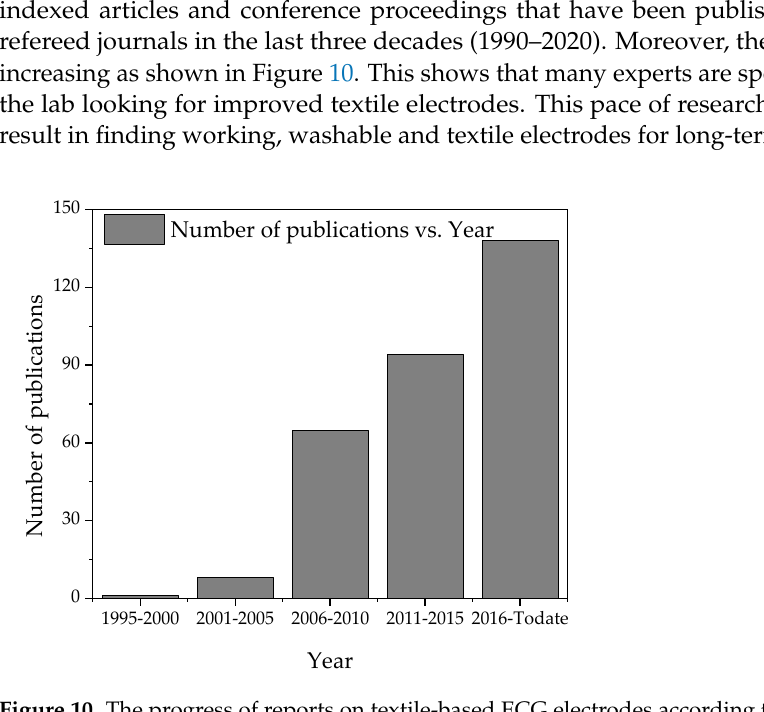
Figure 10. The progress of reports on textile-based ECG electrodes according to Web of Science core collections.